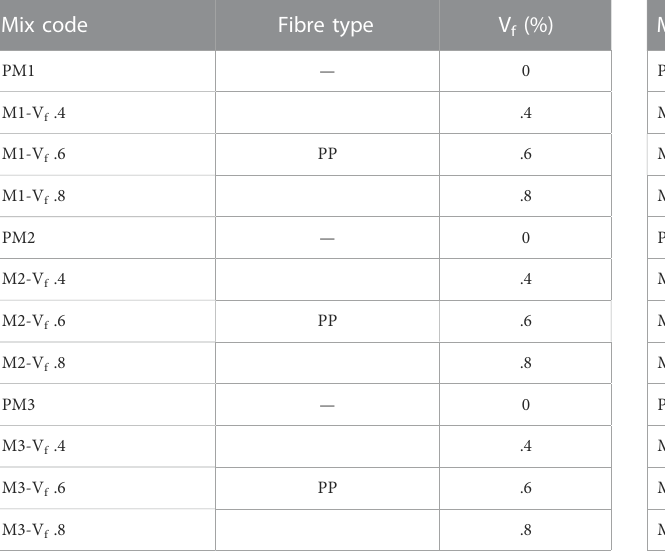
TABLE 4 Fibre V f (%) for mortar mixes. TABLE 5 Fibre V f (%) for cement